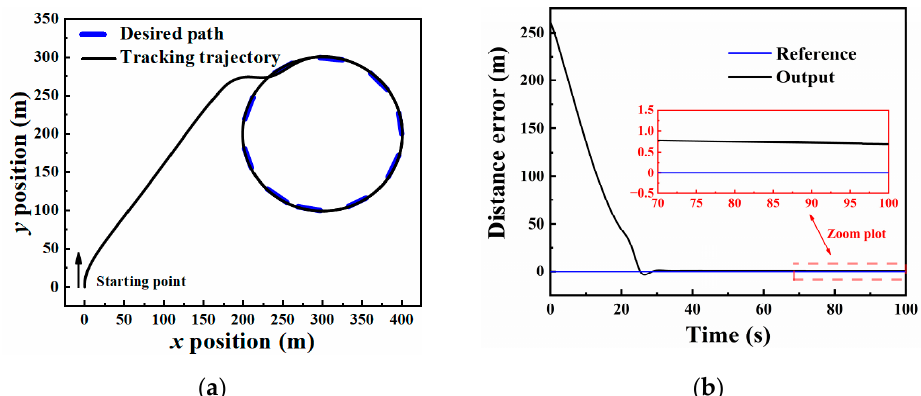
( b ) Figure 26. Comparison of vector field guidance law and L 1 guidance law: ( a ) flight trajectory; ( b ) distance error. Although the application of the L 1 guidance law has a smaller steady-state error, it is only suitable for the case that the aircraft is not far from the path due to some assumptions